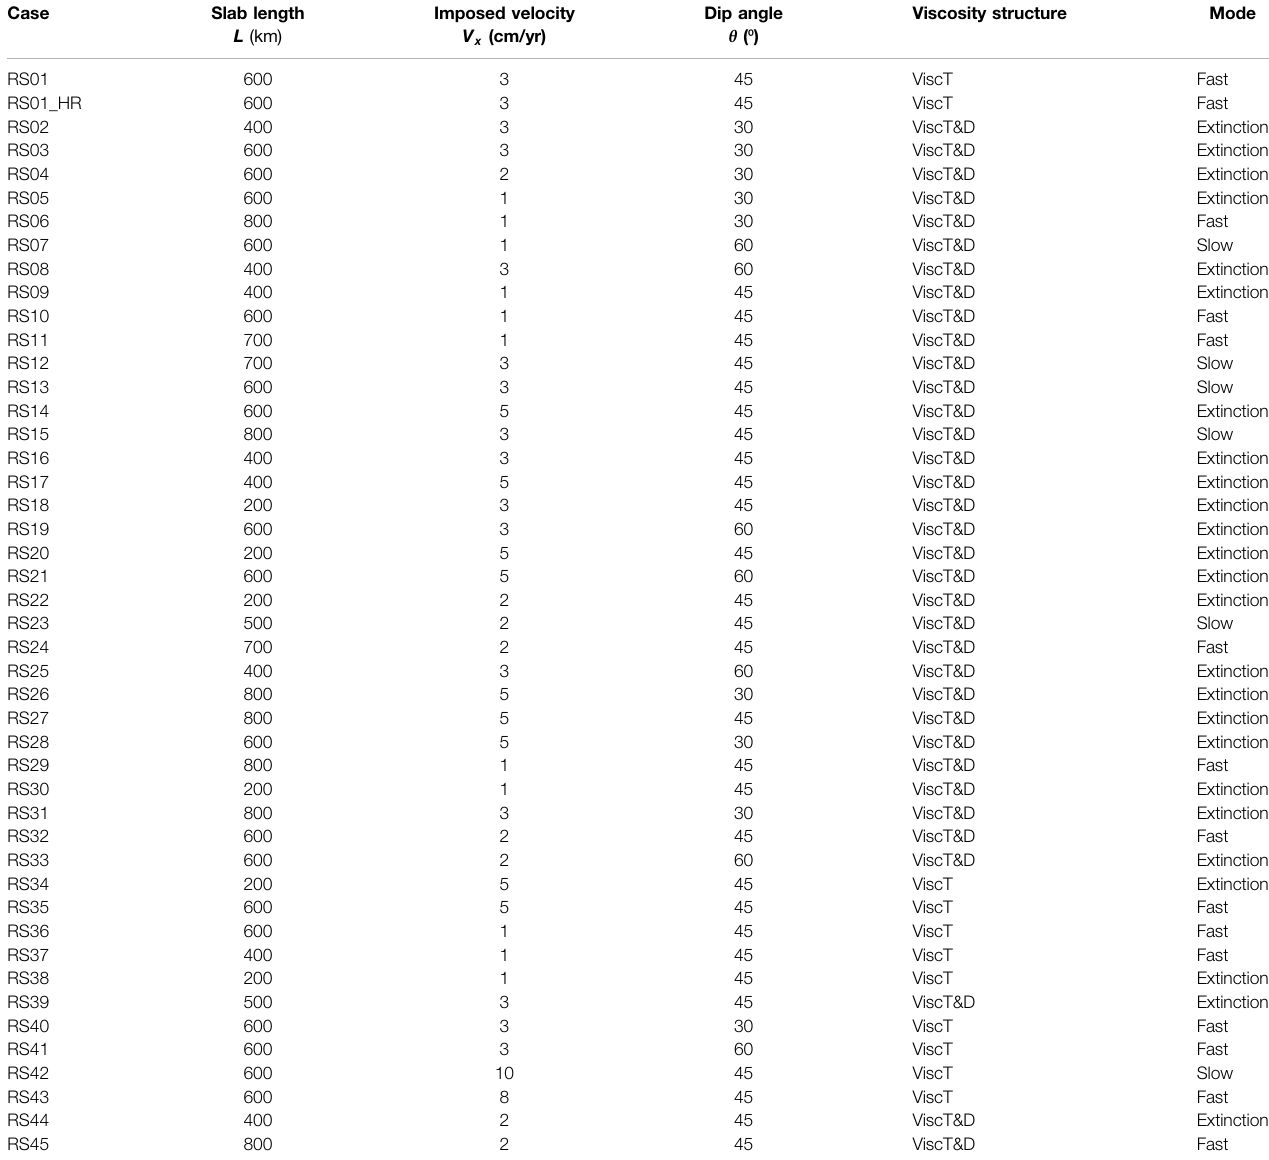
TABLE 2 | Case parameters and resulting modes of MOR subduction. Case Slab length L